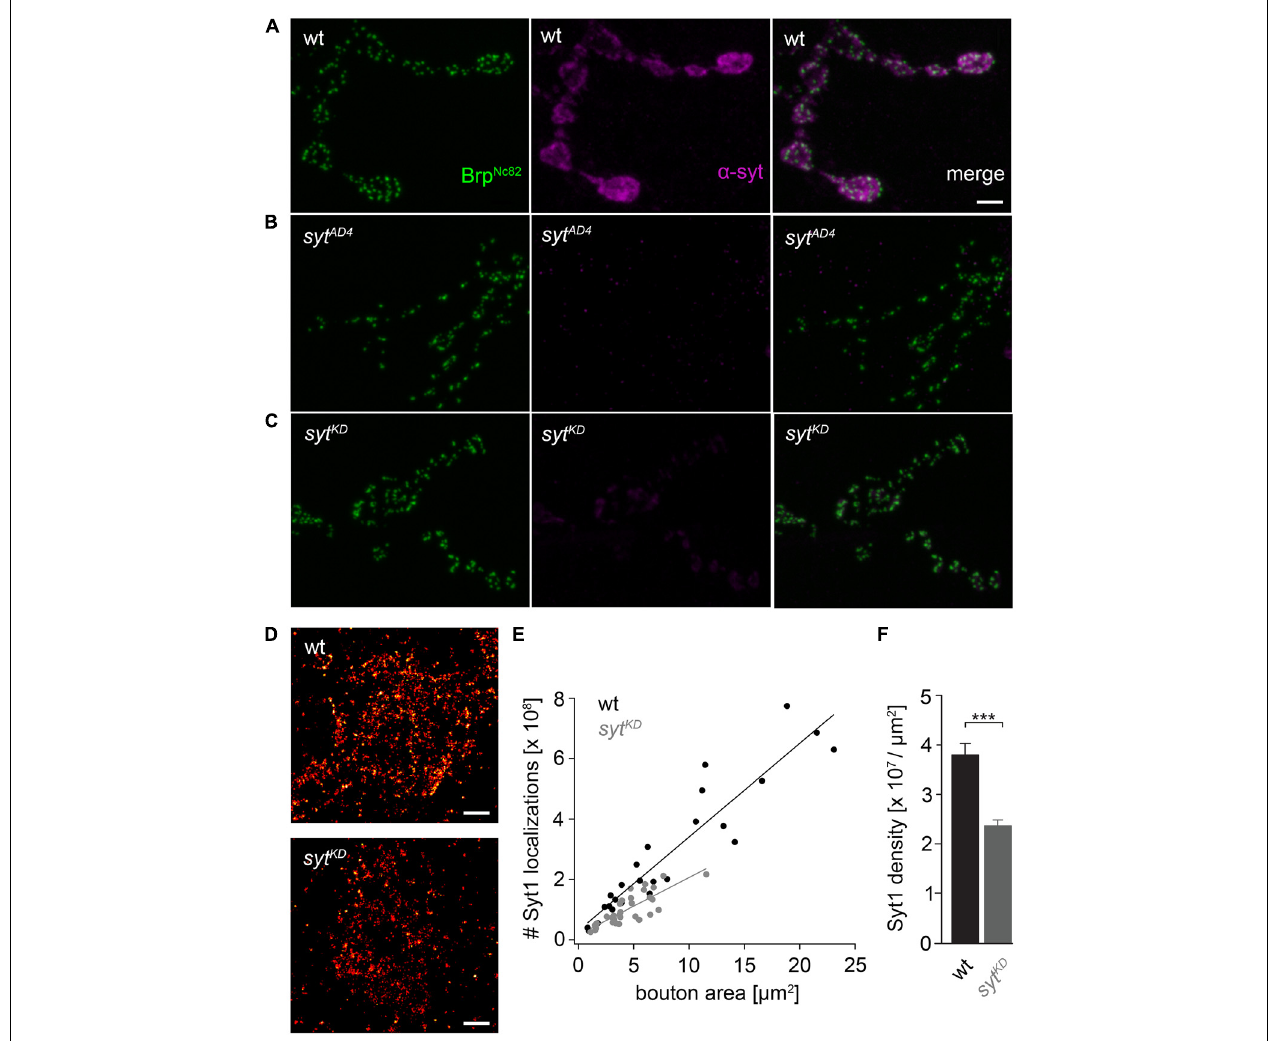
FIGURE 2 | Ribonucleic acid interference decreases presynaptic Syt protein levels. (A) Drosophila wt NMJ on larval abdominal muscles 6/7 stained with antibodies against Brp (Brp Nc82 , green) and Synaptotagmin ( α -Syt, magenta). Brp demarks individual AZs, whereas Syt labels synaptic vesicles predominately distributed around the bouton circumference. (B) The α -Syt signal is absent in Syt null mutans ( syt AD4 ) and (C) strongly reduced after Syt knock-down ( syt KD ) through presynaptically ( ok6-GAL4 ) driven RNA